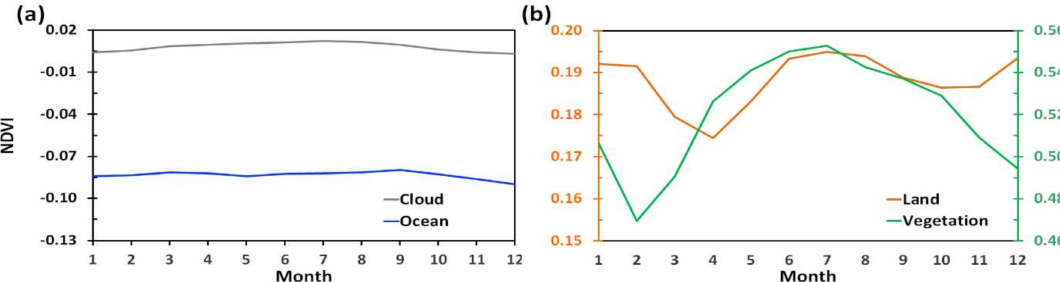
Figure 11. Monthly average Normalized Difference Vegetation Index (NDVI) over ( a ) cloudy and cloud-free ocean, ( b ) cloud-free bare (vertical axis on the left side) and vegetated (vertical axis on the left side) land for the year 2016. The ERTI index was used to discriminate between reflector